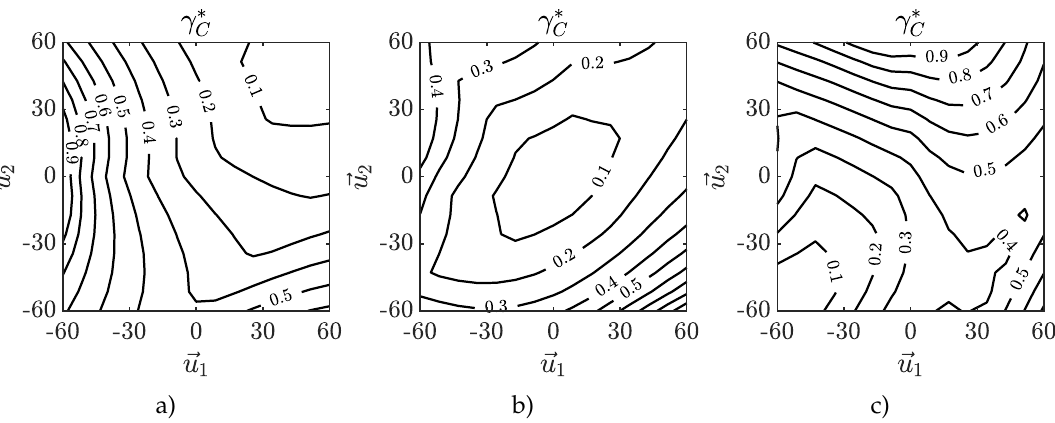
Figure 7. Normalized isotropy iso-curves: ( a ) 60 mm along (cid:126) u 3 , ( b ) 0 mm along (cid:126) u 3 , ( c ) − 60 mm along (cid:126) u 3 .